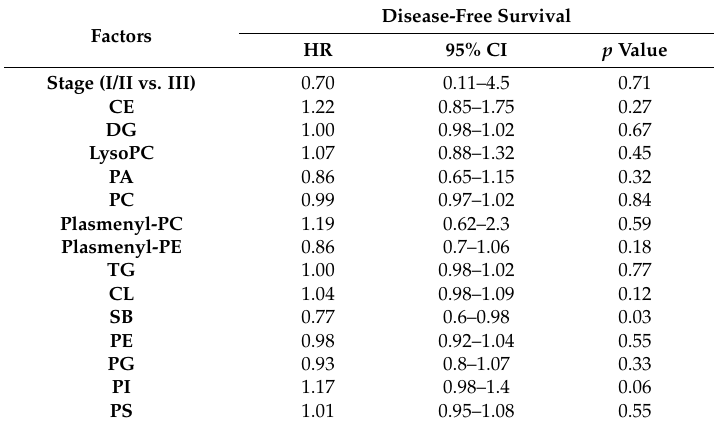
Table 2. Multivariate Cox regression analysis to identify prognostic factors in primary TNBC tumors.